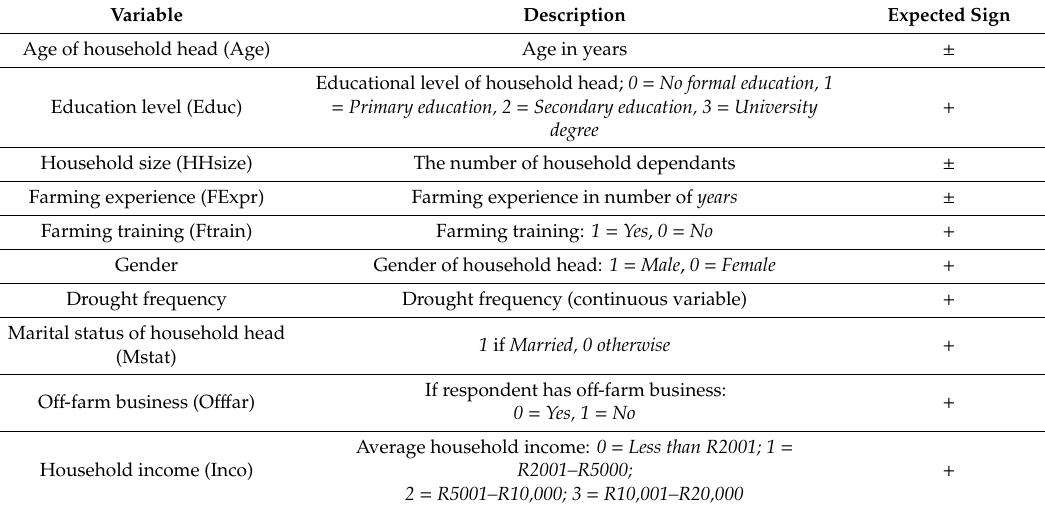
Table 1. Definition of independent variables for multinomial logit